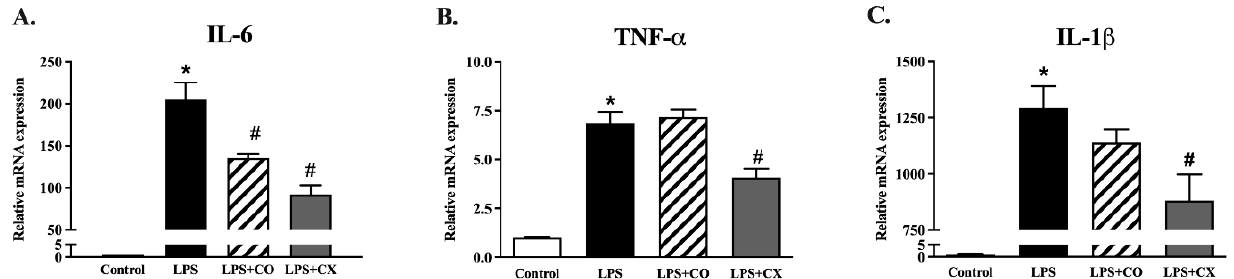
Figure 2. The effects of CO on the gene expression of proinflammatory cytokines. LPS-activated RAW 264.7 cells were incubated with CO for 24 h and the inflammatory cytokine gene expression was measured. During the 24 h of experiments, cells were given either 2% CO or 10 µ M CX with or without LPS. qPCR was used for the gene expression of IL − 6, IL − 1 β , and TNF −α ( A – C ). Values displayed are mean ± S.E.M ( n = 5), * p < 0.05 vs. control and # p < 0.05 vs. LPS.